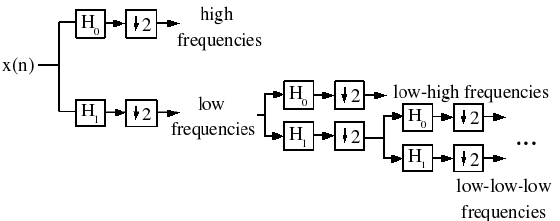
Figure 2. Three decomposed levels of MRA